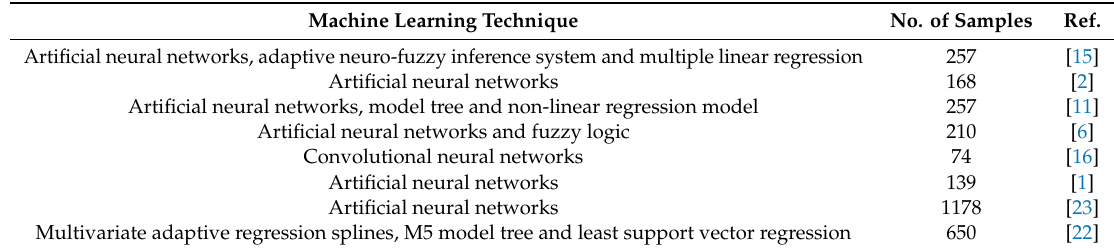
Table 1. Studies on using ML techniques for prediction of RAC compressive